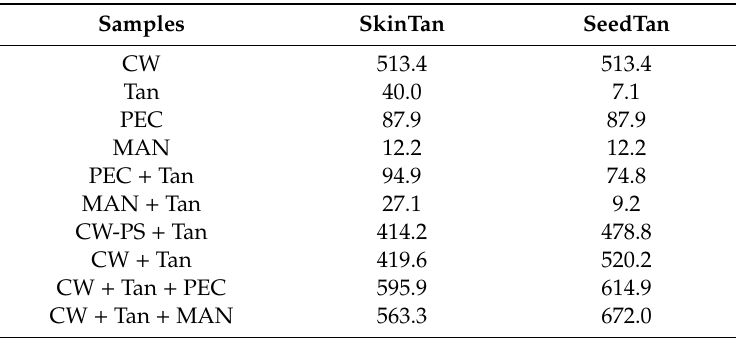
Figure 8. Analysis of the mass distribution of polysaccharides by SEC. Comparison of the polysaccharides released in the interaction tests between SeedTan, MAN, CW, and CW-PS. Table 5. Total area measured in the SEC analysis for the soluble polysaccharides in the model solution after the interaction